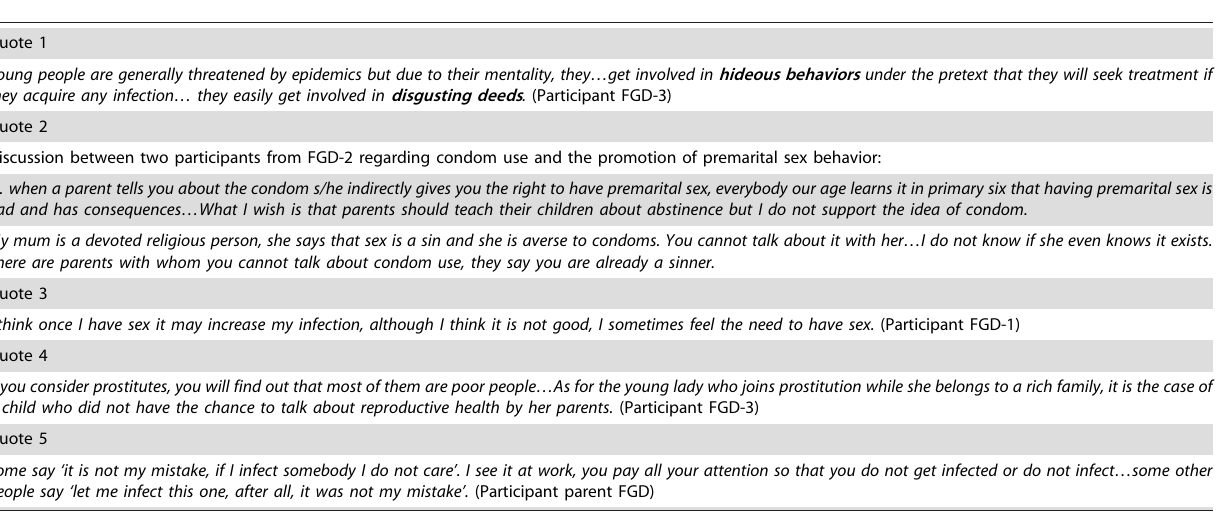
Table 1. Quotes regarding talking about